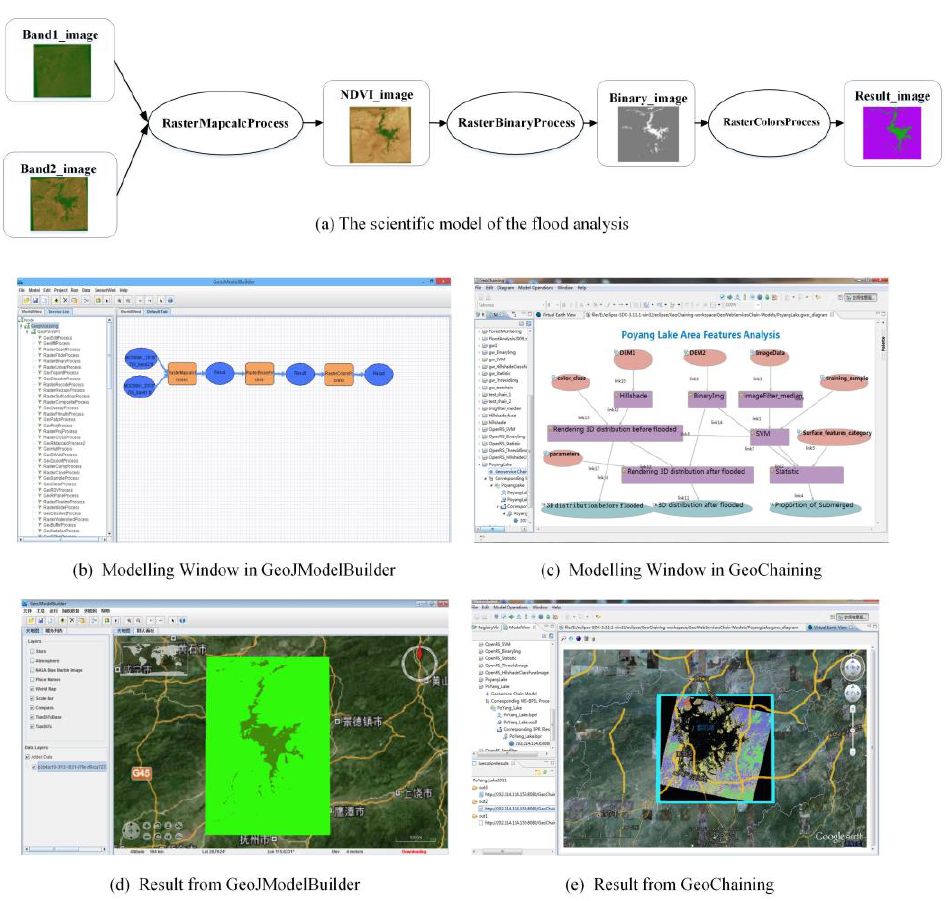
Figure 4. The geoprocessing modelling on flood analysis in GeoJModelBuilder and GeoChaining.